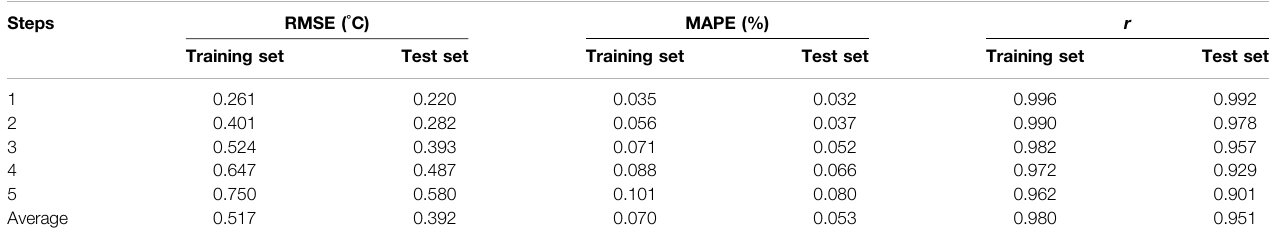
TABLE 3 | Performance of multistep prediction model based on LSTM.